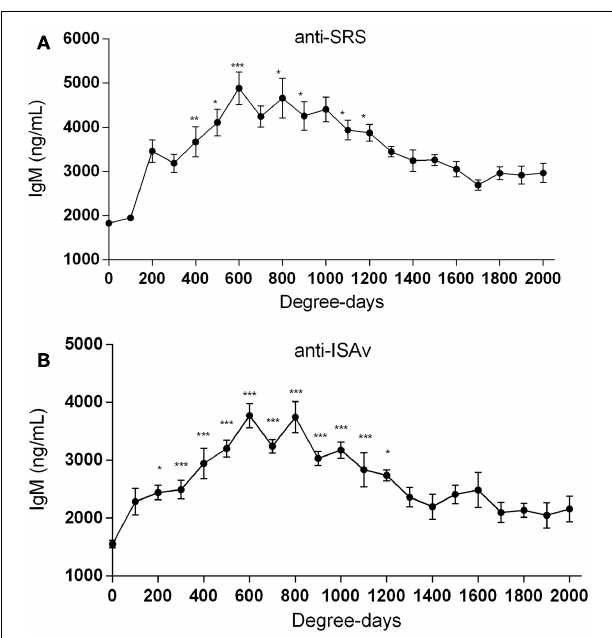
FIGURE 2 | Injectable vaccination increases IgM antibody titers . Salmonids from different aquaculture industries were immunized i.p (0.1mL/fish) with injectable mono or polyvalent vaccines against SRS (A) or ISAv (B) from either Centrovet or other pharmaceutical companies. The IgM concentration was followed up to 2000degree-days. Serum samples were obtained at different degree-days to determine specific anti- P. salmonis and anti-ISAv antibodies through a quantitative ELISA assay. The samples were statistically analyzed by one-way ANOVA – Dunnet post-test. (SRS 120 fish/point, ISAv 65 fish/per point) * p < 0.05; ** p < 0.01; *** p <